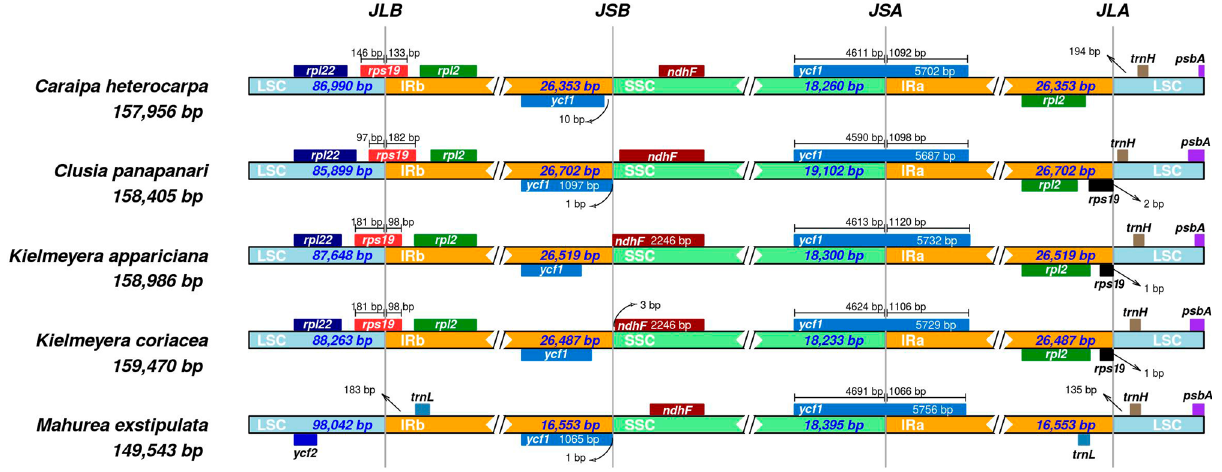
Figure 2. Comparison of the genes flanking the limits of LSC, SSC, and IR regions from the five complete clusioid plastomes assembled. JLB (IRb/LSC), JSB (IRb/SSC), JSA (SSC/IRa) and JLA (IRa/LSC) denote the respective limit in the